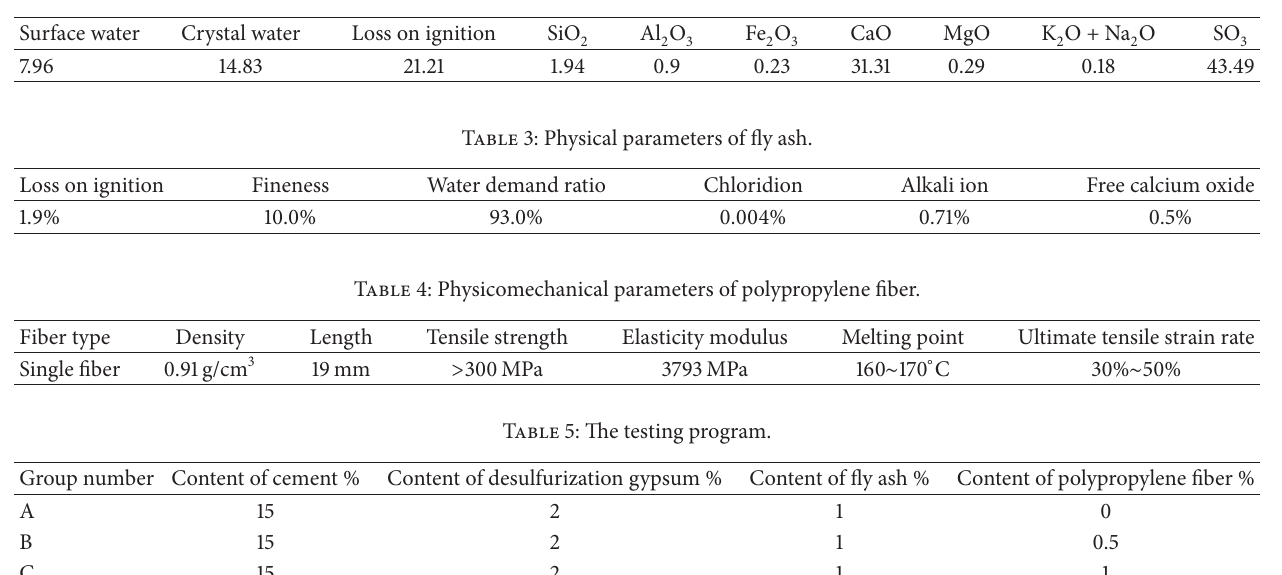
Table 2: Chemical composition of desulfurization gypsum.